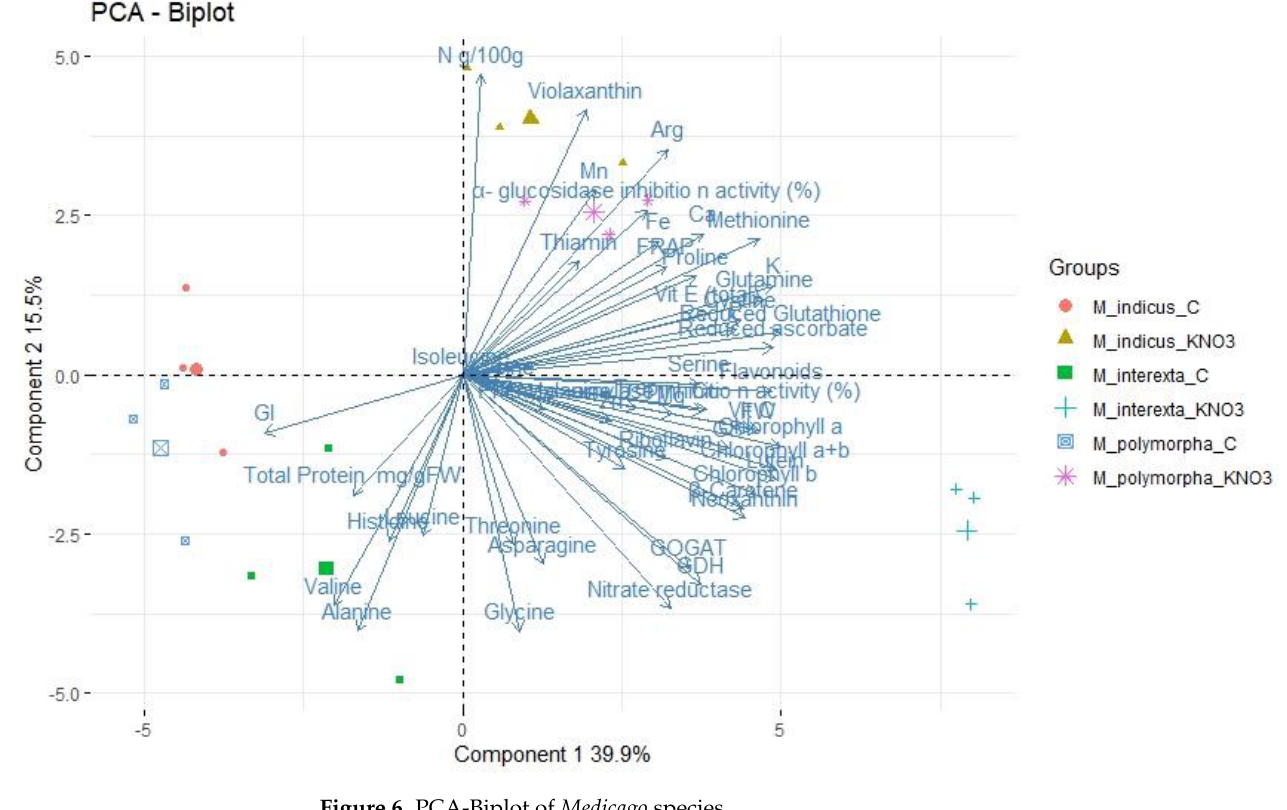
Figure 6. PCA-Biplot of Medicago species.